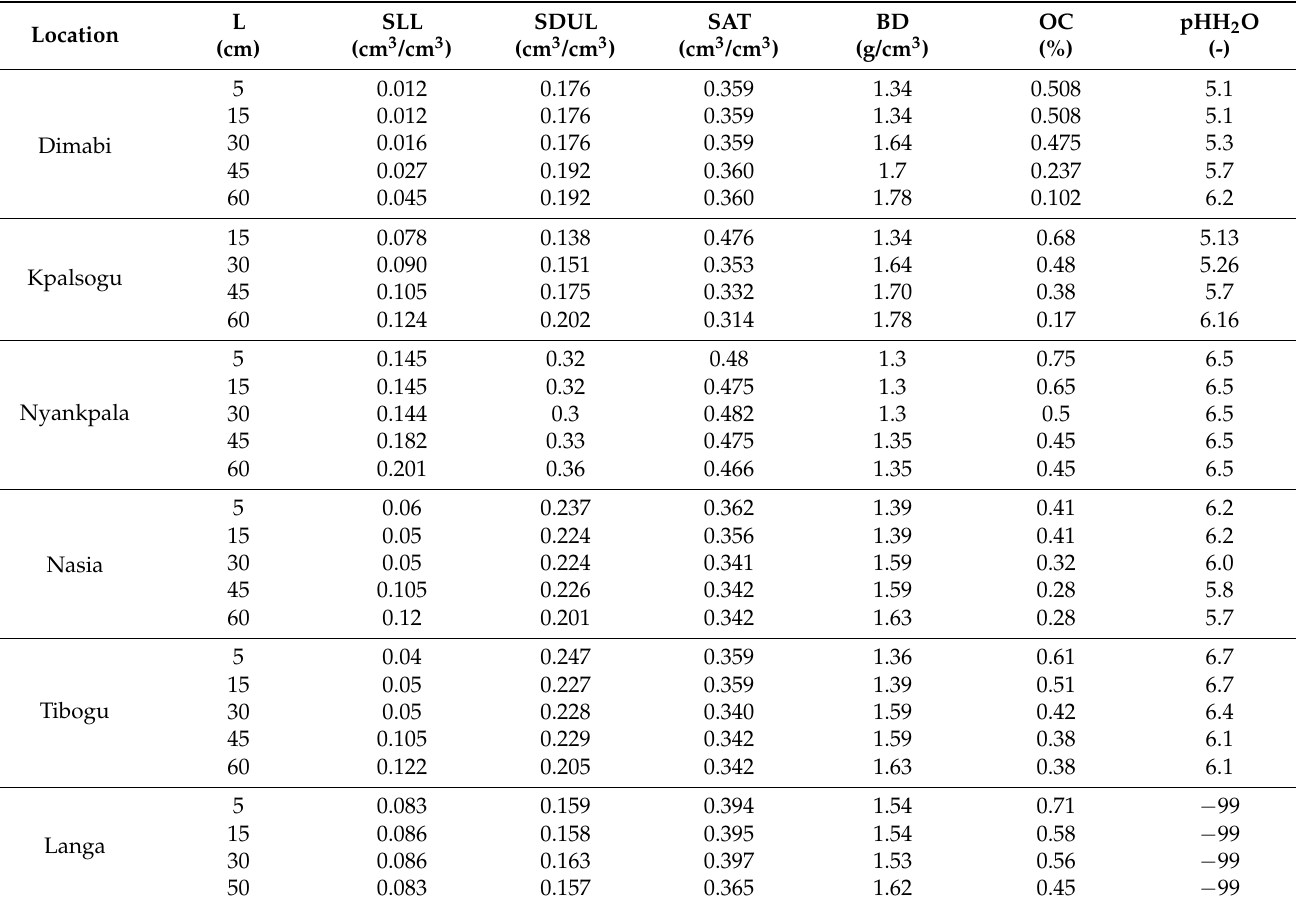
Table 1. Soil parameters used in the evaluation of the